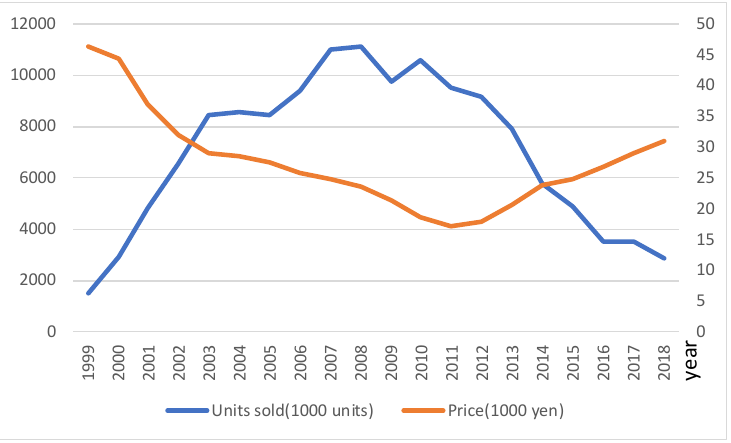
Figure 1. Units sold and price of digital cameras